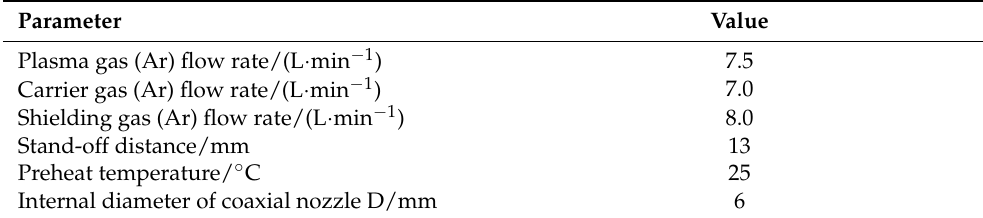
Table 2. Constant parameters during PTA welding process.